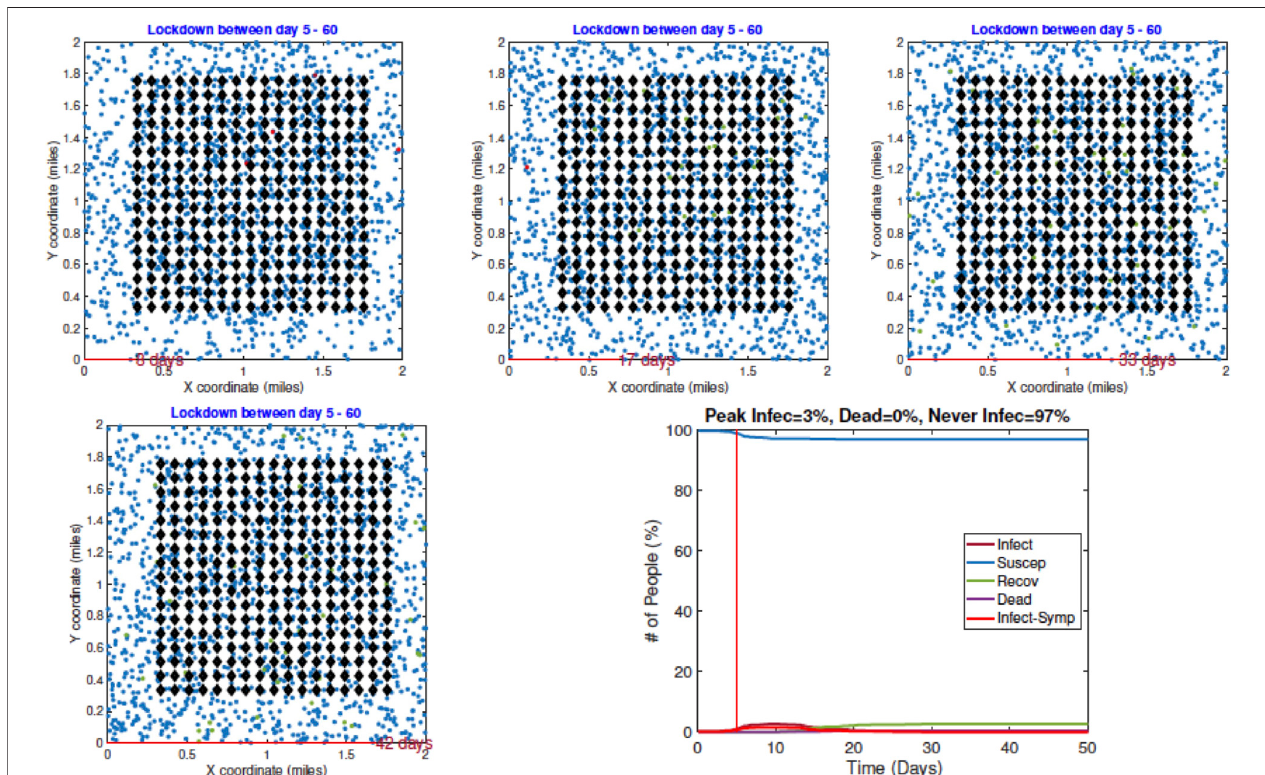
FIGURE8| Example2:displaysofmodeloutputswhenalockdownofinfectedpeople(LD2)isimposedonDay5.Thepandemiccurvesinthebottomrightshowa drastic reduction in infection due to the lockdown.